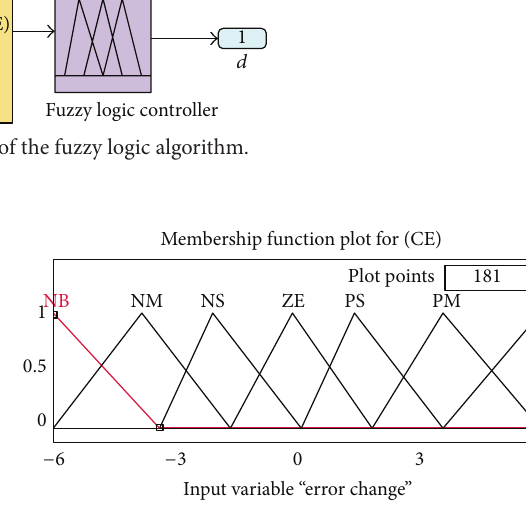
Figure 13: Graphical view of the membership function for change of error signal.